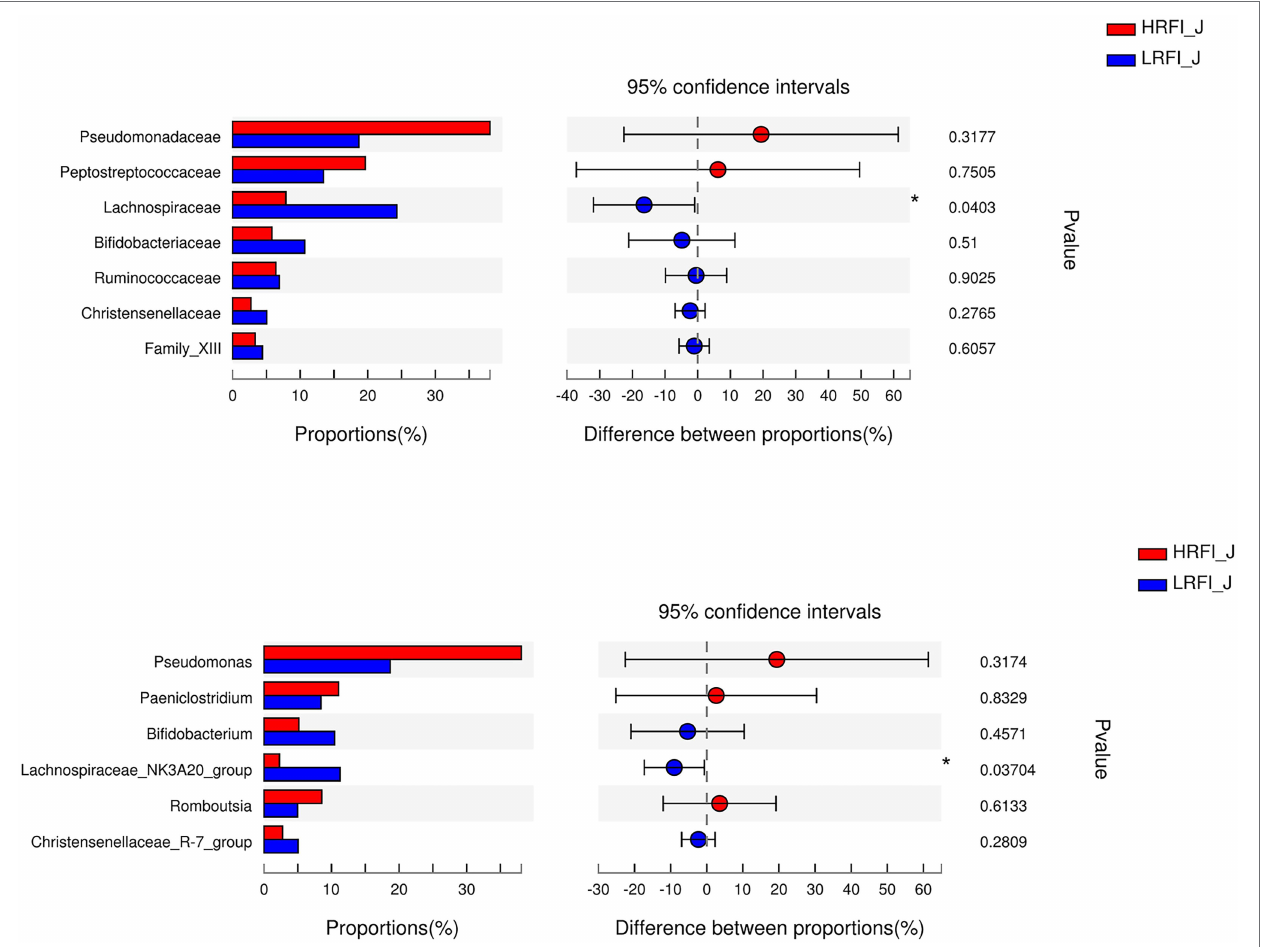
FIGURE 6 | Significantly differential abundant families, and genera (relative abundance >1%) with the jejunum bacteria. Positive and negative differences indicate a greater abundance in the HRFI group and LRFI group, respectively. *Represents 0.01 < p <